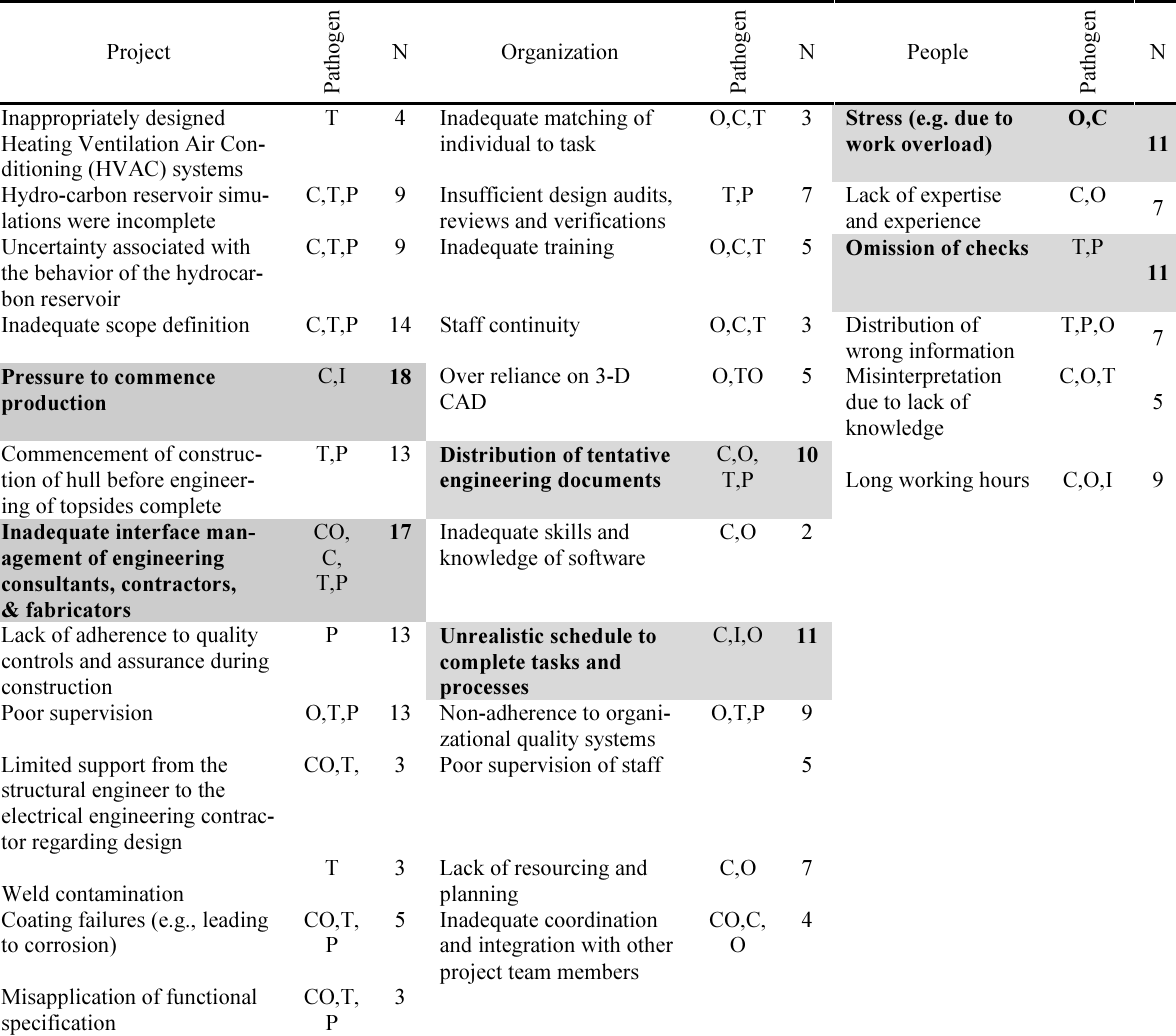
Table 2. Perceived project, organization, and people factors influencing rework from acquired experiences